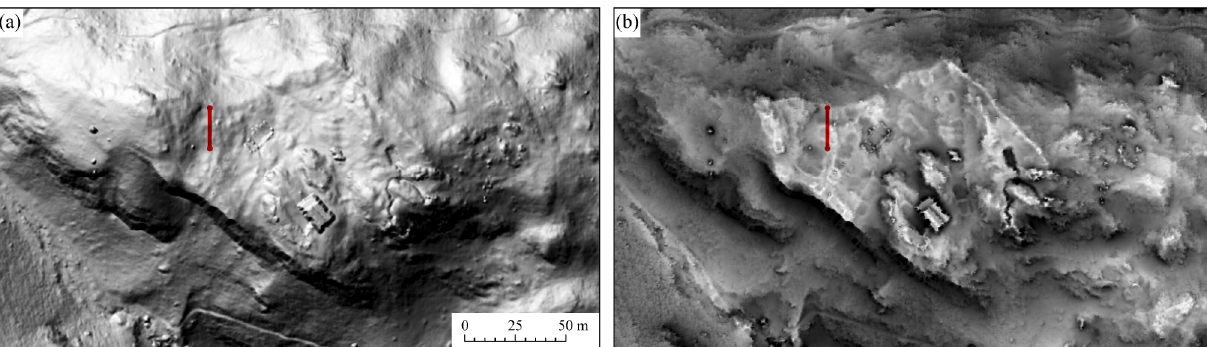
Figure 8. A comparison of analytical hill-shading (a) and SVF based visualization (b) of a DEM generated from lidar data (0.5 m spatial resolution), for the archaeological site at Tonovcov grad (Slovenia). The remains of the building outlines and defense walls are clearly recognizable on the SVF based visualization. The profile location from Figure 7 is represented by the red line. SVF was computed in 16 directions with a 10 m search radius.